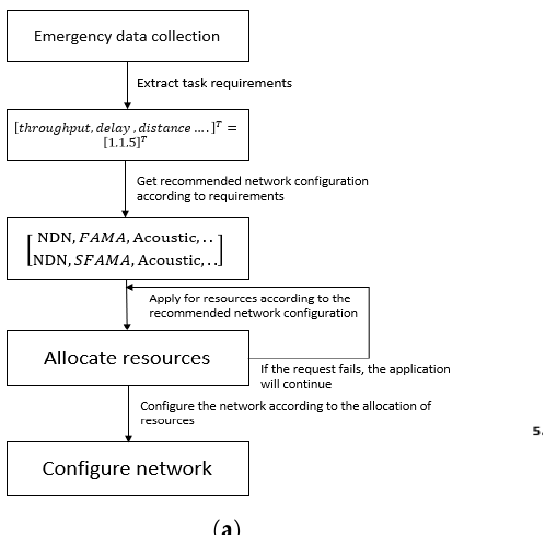
( a ) ( b ) Figure 19. ( a ) Showing 10 s average packet transmission speed of MMNET and acoustic communication; ( b ) the total number of contracts in the whole simulation process. In order to evaluate the multi-mode routing capability of MMNET, we considered a classic underwater data acquisition scenario. Multiple acquisition nodes were deployed around a sink node and acoustic communication was used between nodes. The transmission rate of network packets conformed to the Poisson distribution of λ = 0.4 packets per second. Each node used MMNET to deploy address-based routing and NDN-based routing. The simulation time was 600 s. Assuming that the application had special interest in 5% of the data packets, it needed to be recollected. Figure 20a–c showed the ratio of the actual received packets to the expected packets when there were three collection nodes, six collection nodes and nine collection nodes, respectively. Because NDN-based packets needed to send interest packets first, they occupy more network resources and were less efficient than MMNET and address-based routing. However, when the application was interested in some packets, the method based on NDN would reduce the sending of interest packets due to its content aggregation function, while the address-based method needed to send interest packets many times. MMNET used two methods at the same time, which was more efficient. As could be seen from the Figure 20a–c, with the increase of nodes, the performance of address-based routing was gradually declining because it did not have aggregation function. The performance of the NDN- based routing method was low because it needed to send interest packets when collecting data. MMNET provided services for applications in various ways, which cpuld meet the needs of applications to a large extent.